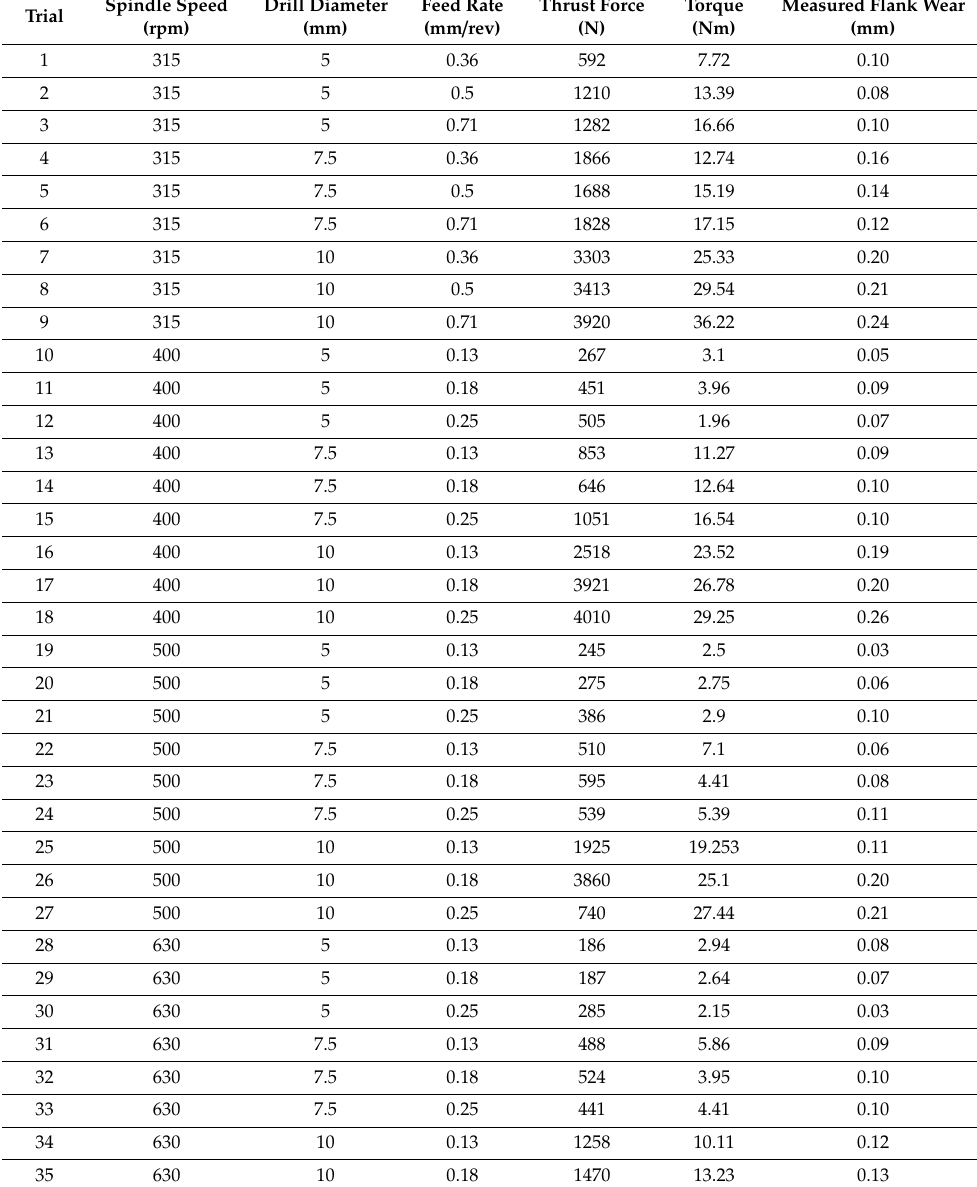
Table 4. Experimental data for Copper workpiece